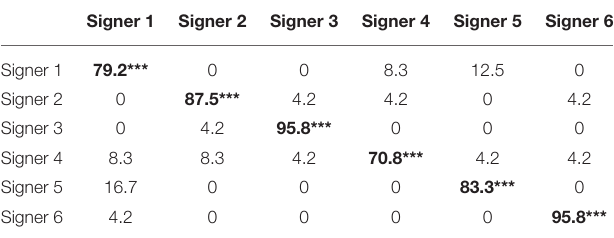
between normalizations. They revealed a significant increase TABLE 1 | Confusion matrix displays the percentage of identifications of the model, averaged across the 24 test examples (for posture-normalized